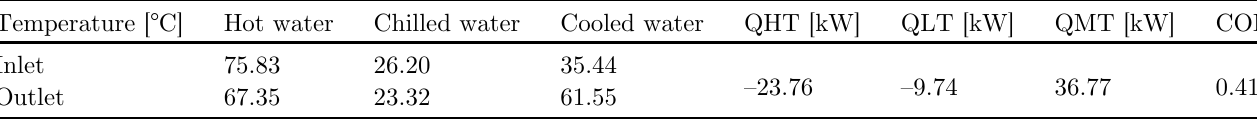
Fig. 7. Temperature variation at 75 ° C/25 ° C/35 ° C. Table 2. Temperature average and speci fi c heat capacity at 75 ° C/25 ° C/35 ° C. Temperature [ ° C]